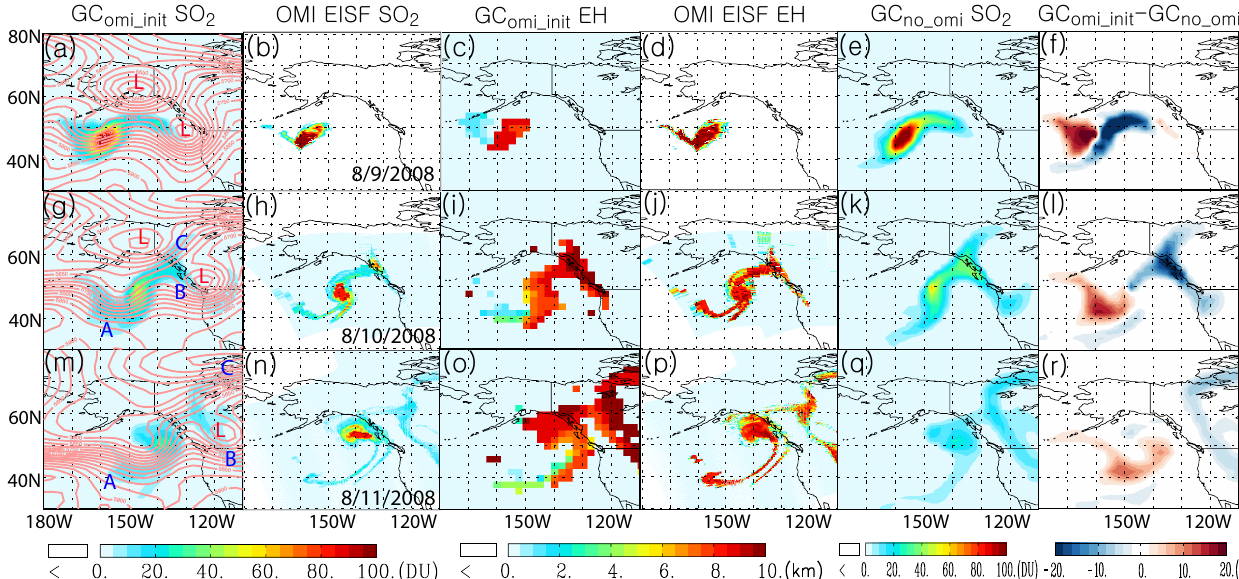
Fig. 2. (a) and (c) : distribution of SO 2 column amount (in DU) and effective height (EH) (in km) of SO 2 on 9 August 2008 as simulated by GEOS-Chem (GComi init) with model initiation of OMI EISF retrieved SO 2 on 8 August 2012; (b) and (d) : the respective counterparts of (a) and (c) retrieved from the OMI EISF algorithm; (e) : same as (a) but from GEOS-Chem simulations without model initiation of EISF retrieved SO 2 (GCno omi), and (f) shows the difference between (a) and (e) . (g) – (l) are respectively the same as (a) – (f) but for 10 August 2008. (m) – (r) are the same as (a) – (f) but for 11 August 2008. The pink solid lines in (a) , (g) and (m) are isopleths (at 25m intervals) of the 500hPa geopotential height (in m). L in red in (a) , (g) and (m) shows the location of low pressure systems, while A, B, and C in (g) and (m) respectively mark the three different transport pathways for SO 2 . Subscripts omi init and no omi respectively denote the simulation with and without initialization of OMI SO 2